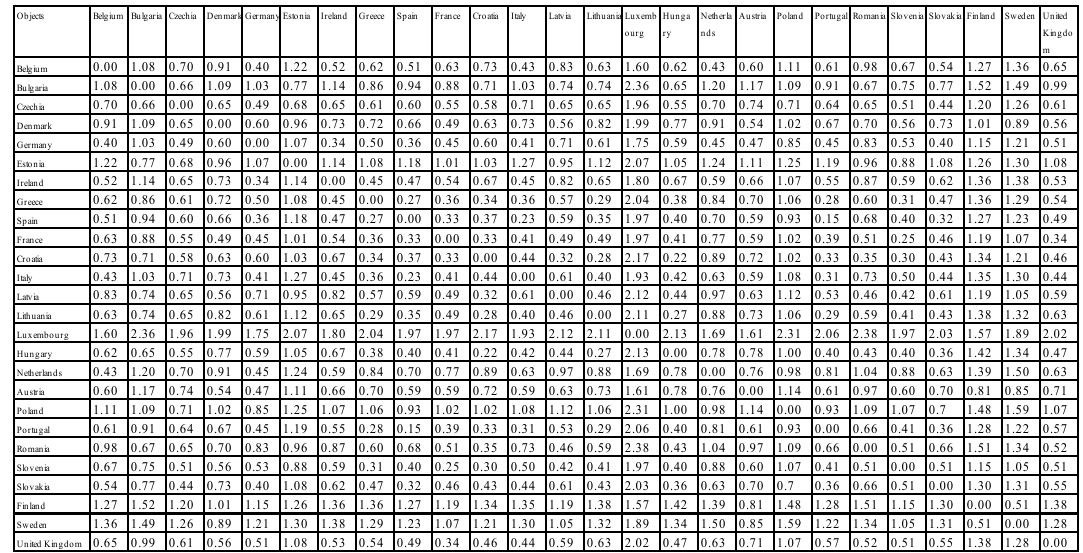
Figure 5. Euclidean distance matrix for 2018 . Source: (own elaboration).